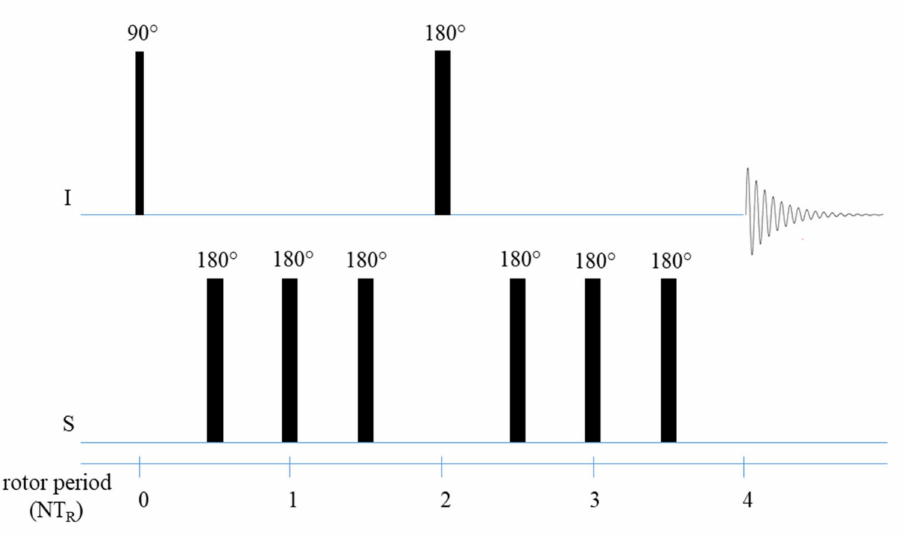
Figure 20. Rotational echo double resonance (REDOR) pulse